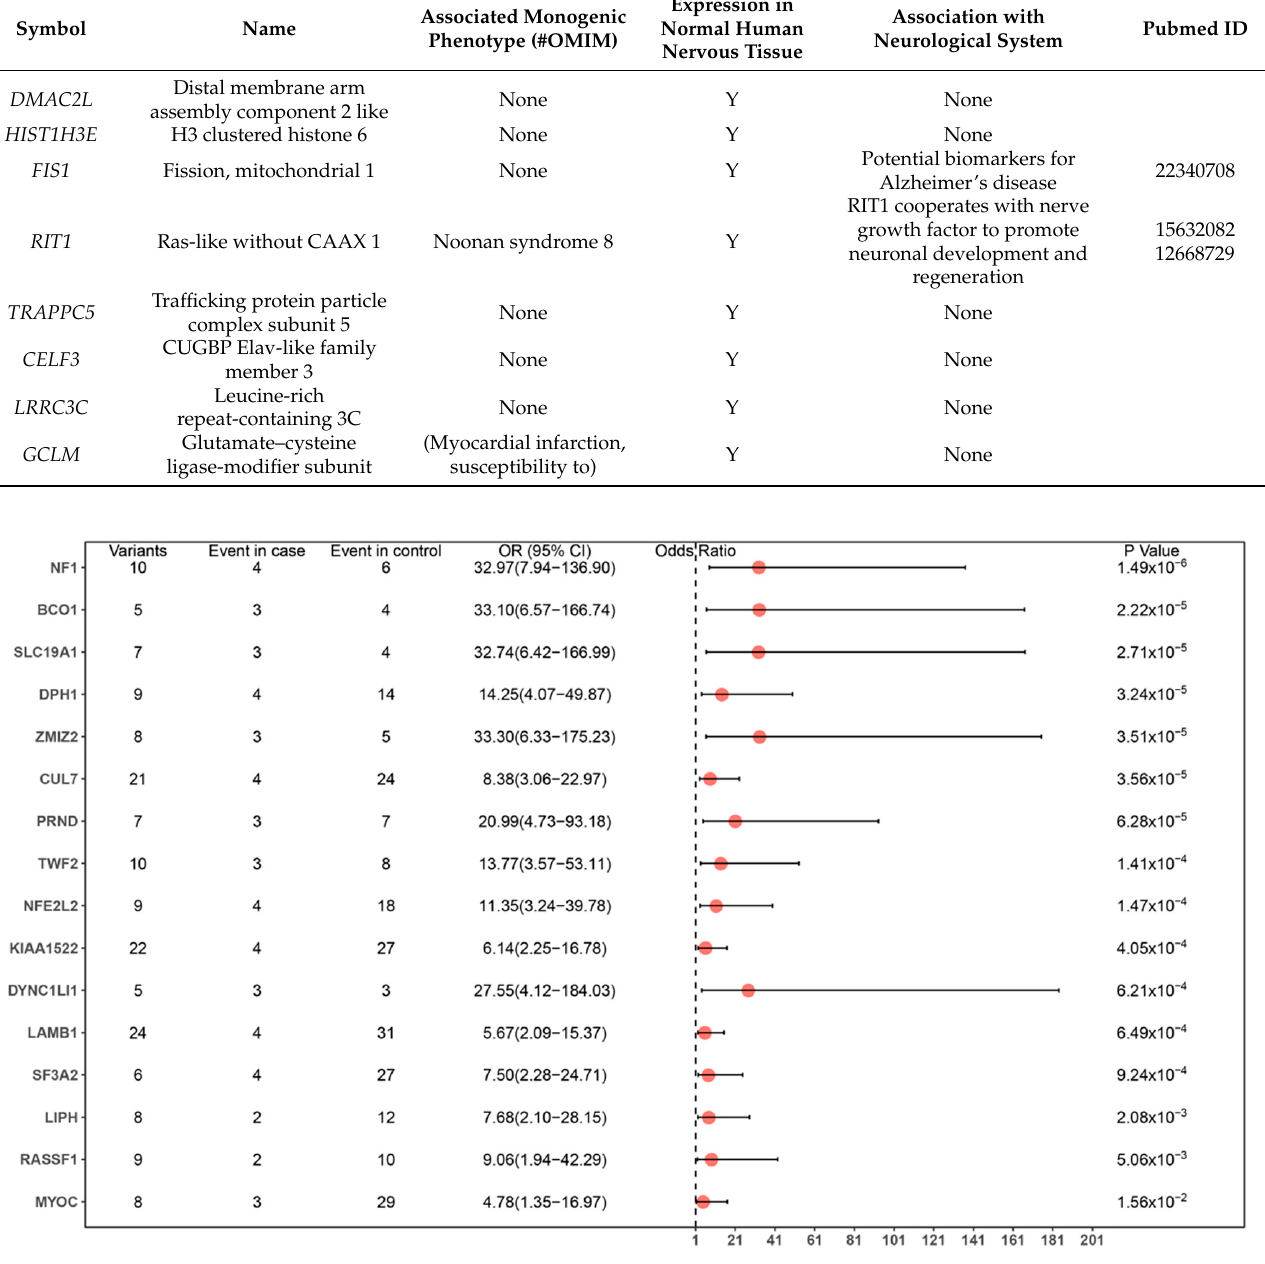
Figure 2. Forest plot showing the odds ratios (ORs), confidence intervals (CIs), and p -values for the association between the rare LOF variants of potential modifier genes (unique variants >= 5) in case and control groups. Analyses were performed on SKAT-O results with a detected signal using Firth logistic regression, adjusting for sex, using the brglm2 R package.